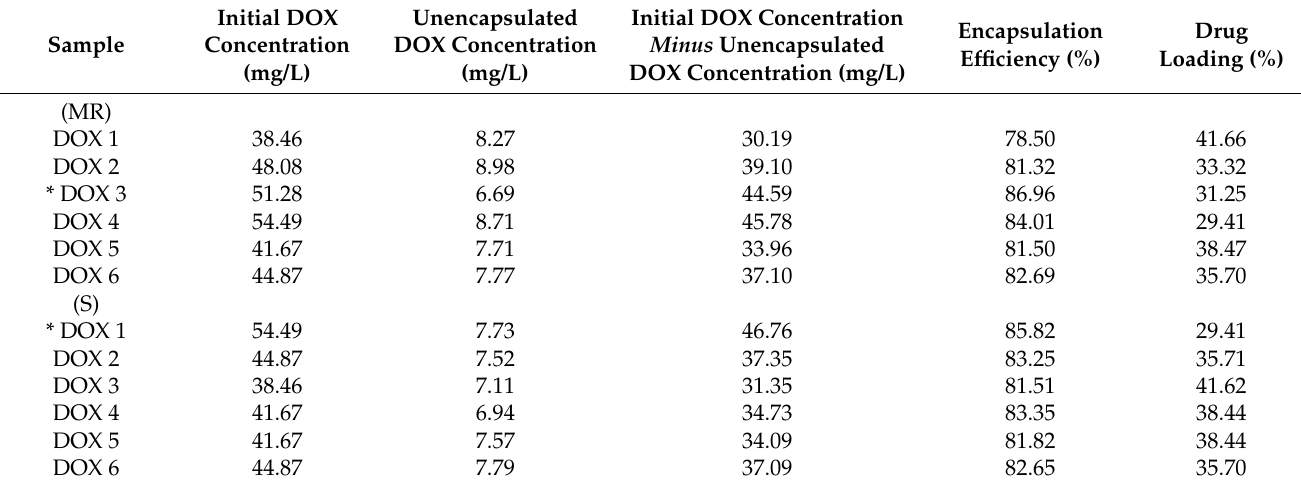
Table 2. Encapsulation efficiency and drug loading in PLGA + DOX microspheres.